Question: Provide a one-line summary of what is displayed.
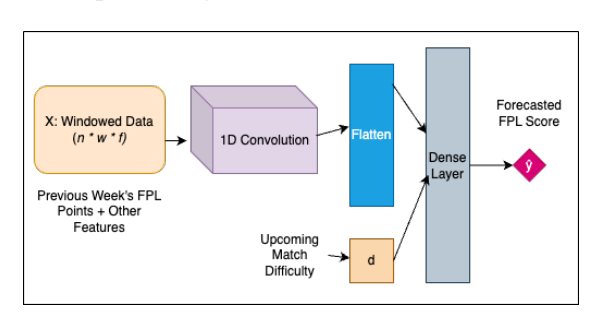
Answer: Custom CNN Architecture for FPL Performance Fore- casting.